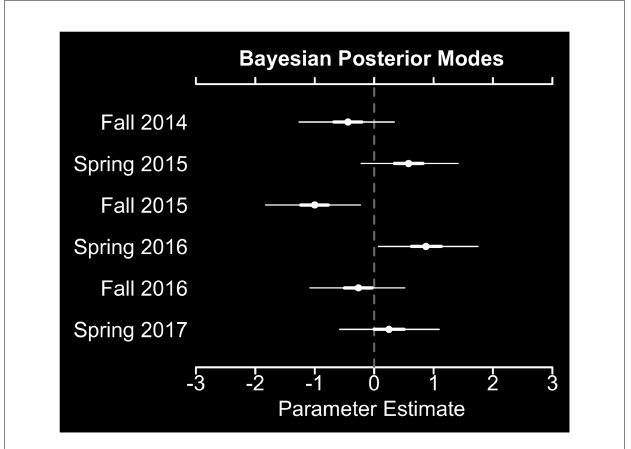
FIGURE 3 Bayesian posterior modes for semester-specific random effects. Thick white lines indicate 50% credible intervals, while thin white lines indicate 95% credible